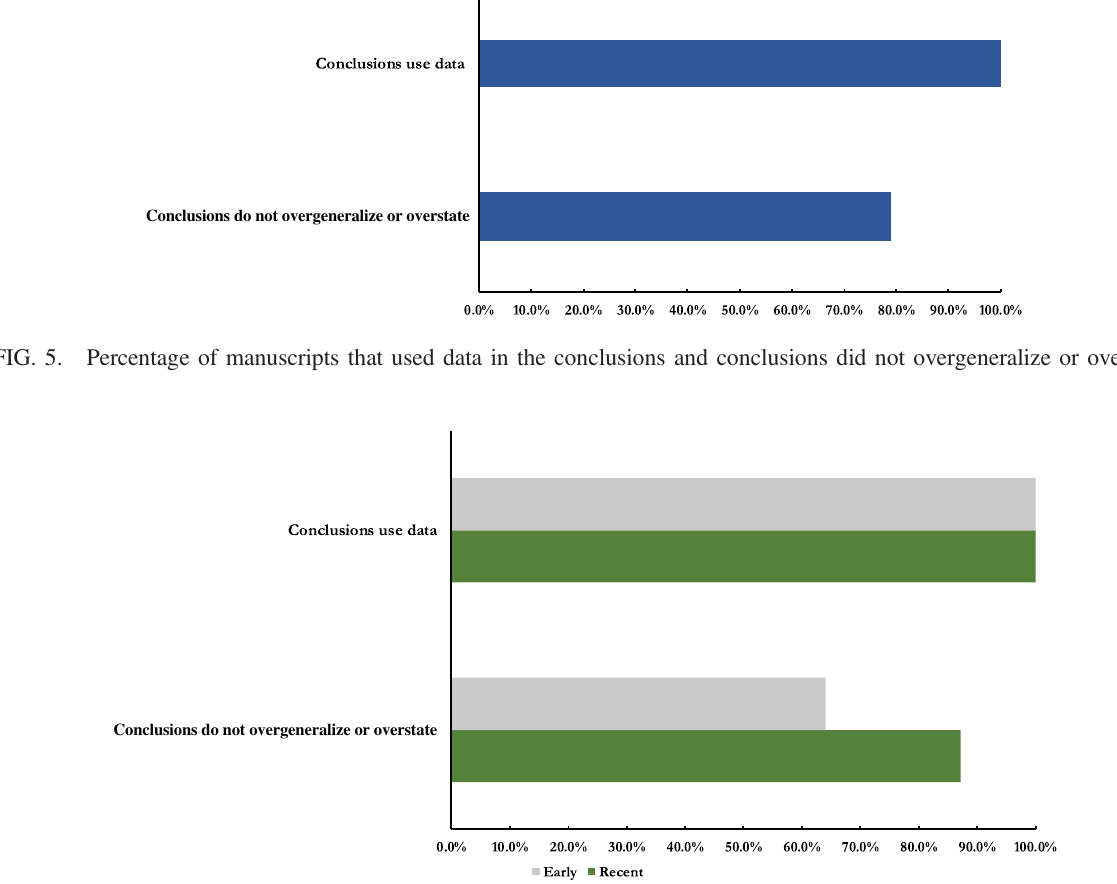
FIG. 6. Percentage of manuscripts that used data in the conclusions and conclusions did not overgeneralize or overstate, disaggregated by recent (2012 – 2017) and early (1992 –